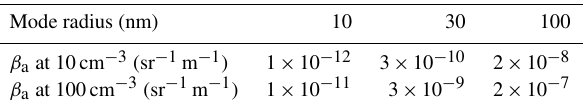
Table 1. The aerosol backscatter coefficients of different aerosol mode radius for the typical aerosol number densities.